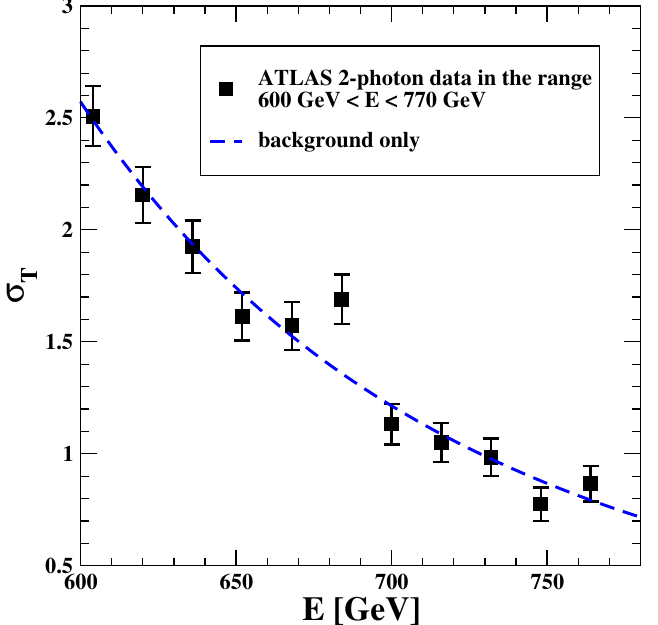
Figure 3. The fit with Equation (22) and σ R = 0 to the data in Table 2, transformed into cross sections in fb. The chi-square value is χ 2 = 14 and the background parameters A = 1.35 fb and ν = 4.87.